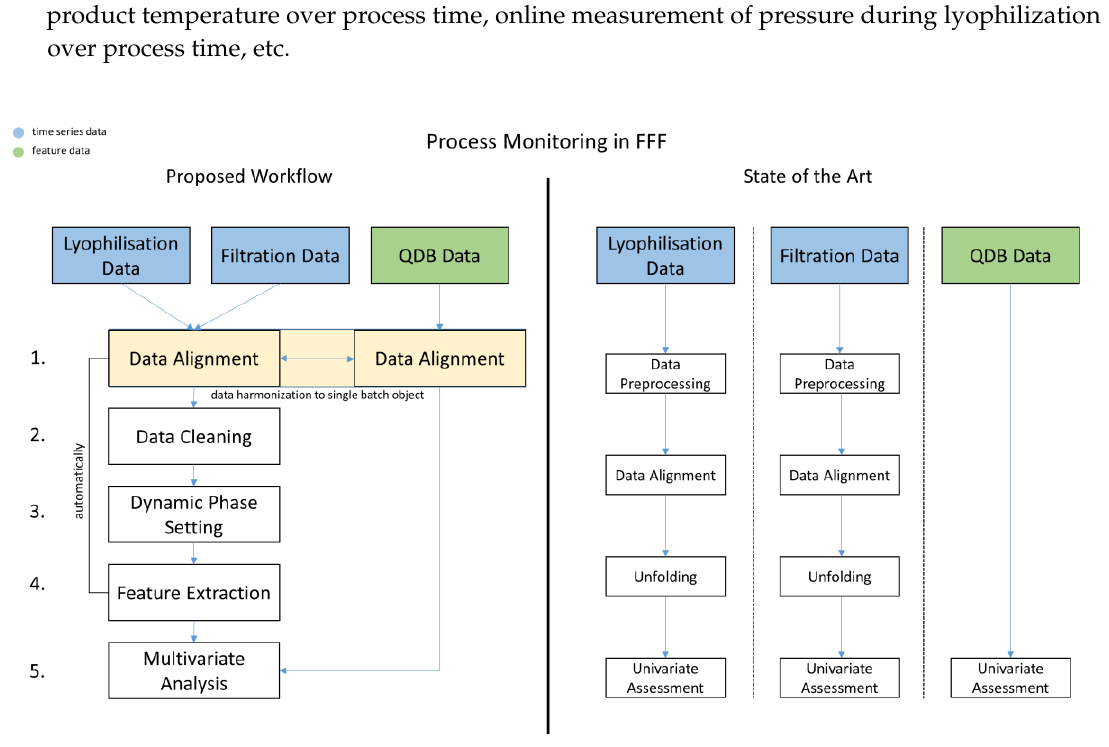
Figure 1. Comparison of workflows for process monitoring in formulation, fill, and finish (FFF) processes with respect to filtration, lyophilization and quality database (QDB) data. Compared to the current workflow, the proposed workflow examines the different FFF data sources in more detail, harmonizes the data sources to one single batch object, allowing the analysis of the data in a broader context, and uses their key feature data to perform multivariate analysis. All intermediate steps in the proposed workflow are automated and applicable on further FFF QDB data.